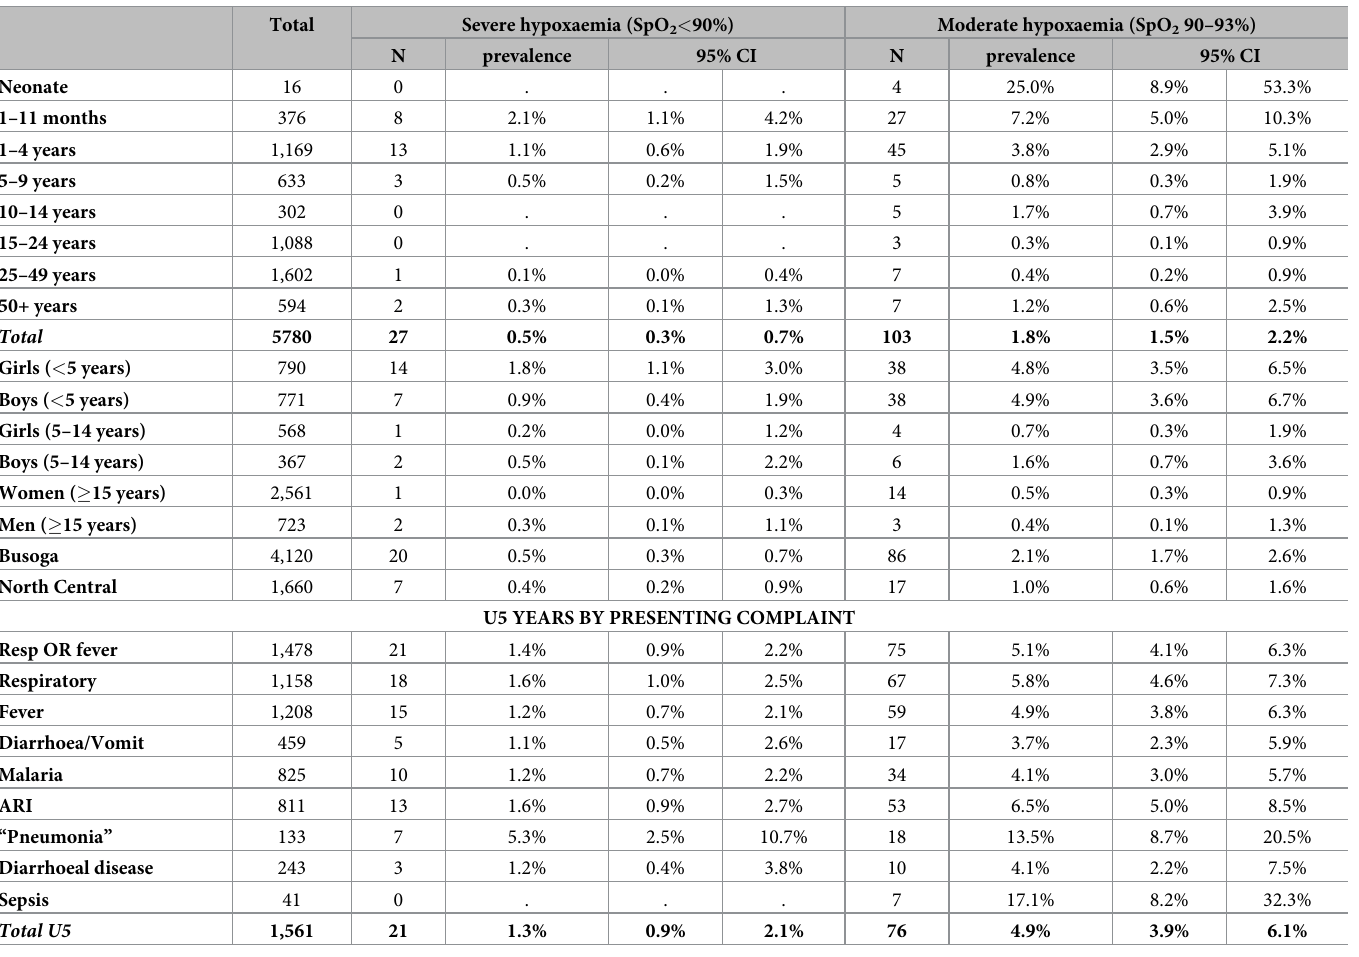
Table 2. Prevalence of moderate (SpO 2 90–93%) and severe hypoxaemia (SpO 2 < 90%) among acutely unwell children, adolescents and adults presenting to primary care (HCIII) facilities in Uganda, Feb-Apr